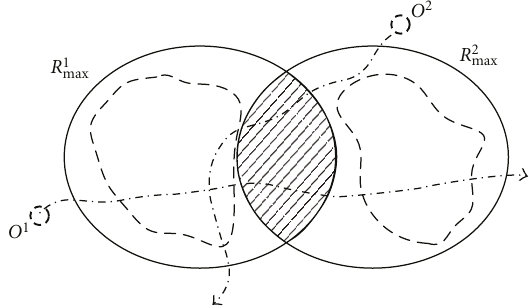
Figure 16: Illustration of the e ff ect of region